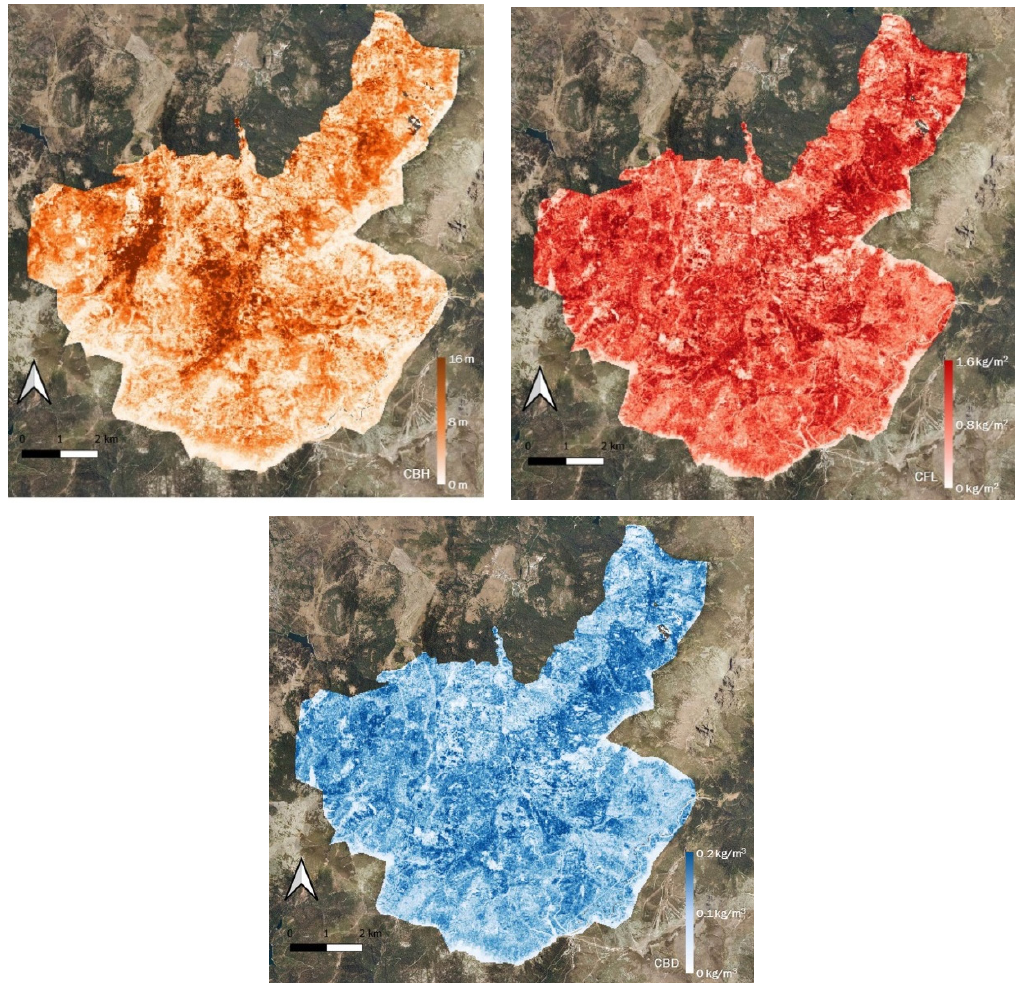
Figure 5. Canopy fuel maps of CBH, CFL and CBD generated at 25-m pixel over the study area derived from the application of the best LiDAR model fitted for each variable (exponential formulation).